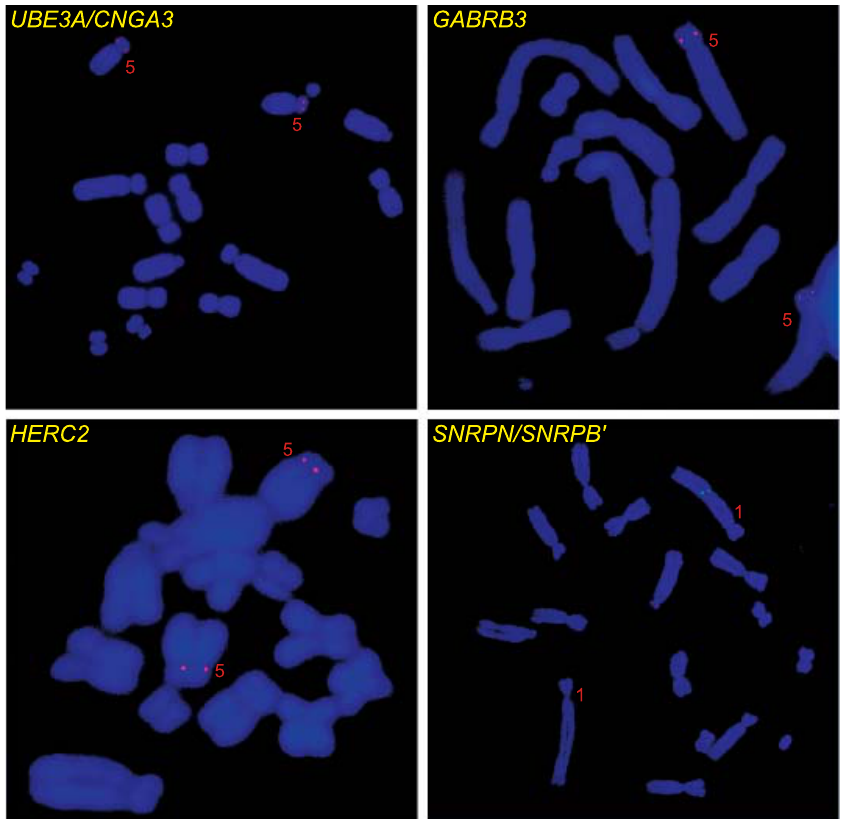
Figure 2. FISH Localization of BACs Containing Tammar Homologs of PWS-AS Genes UBE3A / CNGA3, GABRB3, and HERC2 localize to tammar wallaby Chromosome 5p and SNRPN / SNRPB to Chromosome 1q. DOI: 10.1371/journal.pgen.0020182.g002